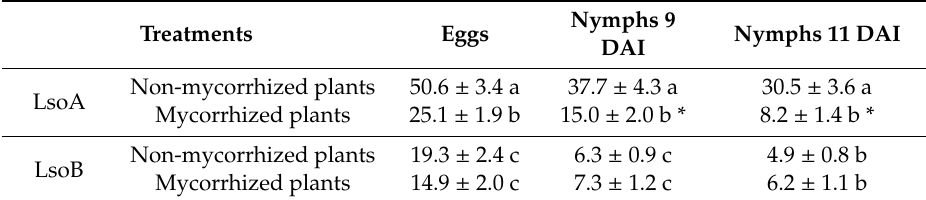
Table 3. Psyllid life history